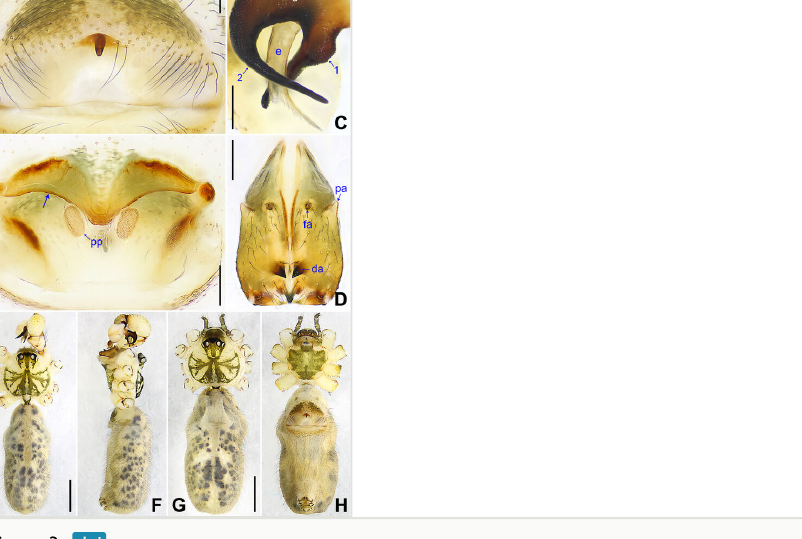
Figure 3. Pholcus maxian sp. nov. A Paratype female, external genitalia, ventral view; B Paratype female, vulva, dorsal view, arrow points at posterior part of arch; C Holotype male, bulbal apophyses, prolateral view, arrows 1–2 point at proximal and distal apophysis; D Holotype male, chelicerae, frontal view; E Holotype male, habitus, dorsal view; F Holotype male, habitus, lateral view; G Paratype female, habitus, dorsal view; H Paratype female, habitus, ventral view. da = distal apophysis, e = embolus, fa = frontal apophysis, pa = proximo-lateral apophysis, pp = pore plate, u = uncus. Scale bars: 0.20 (A–D), 1.00